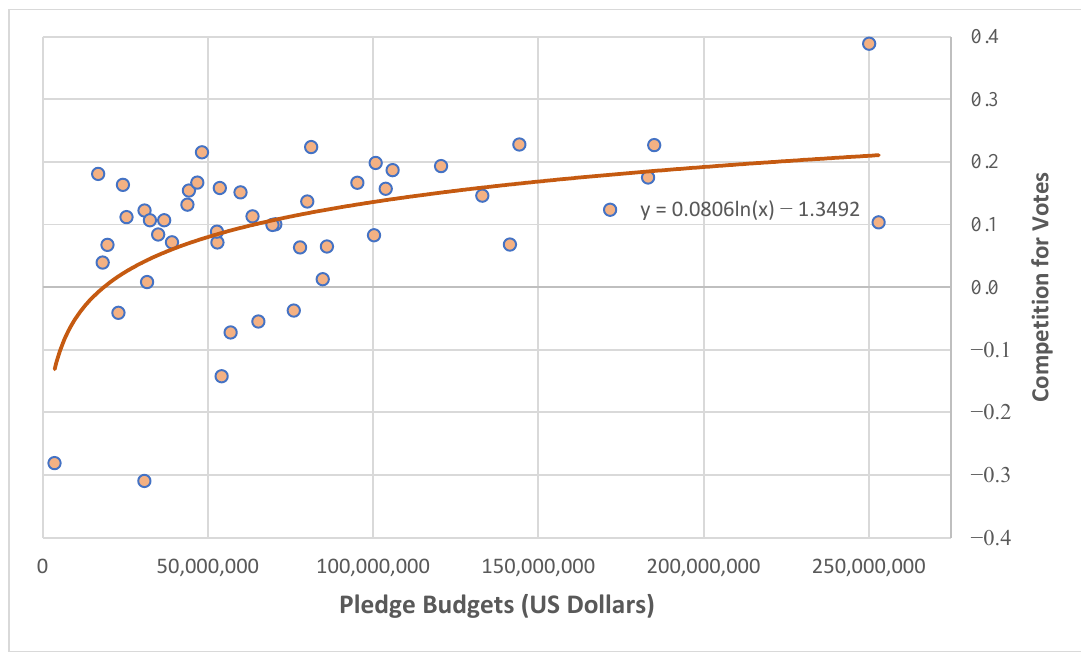
Figure 4. The slope of the competition for votes according to the pledge budget.